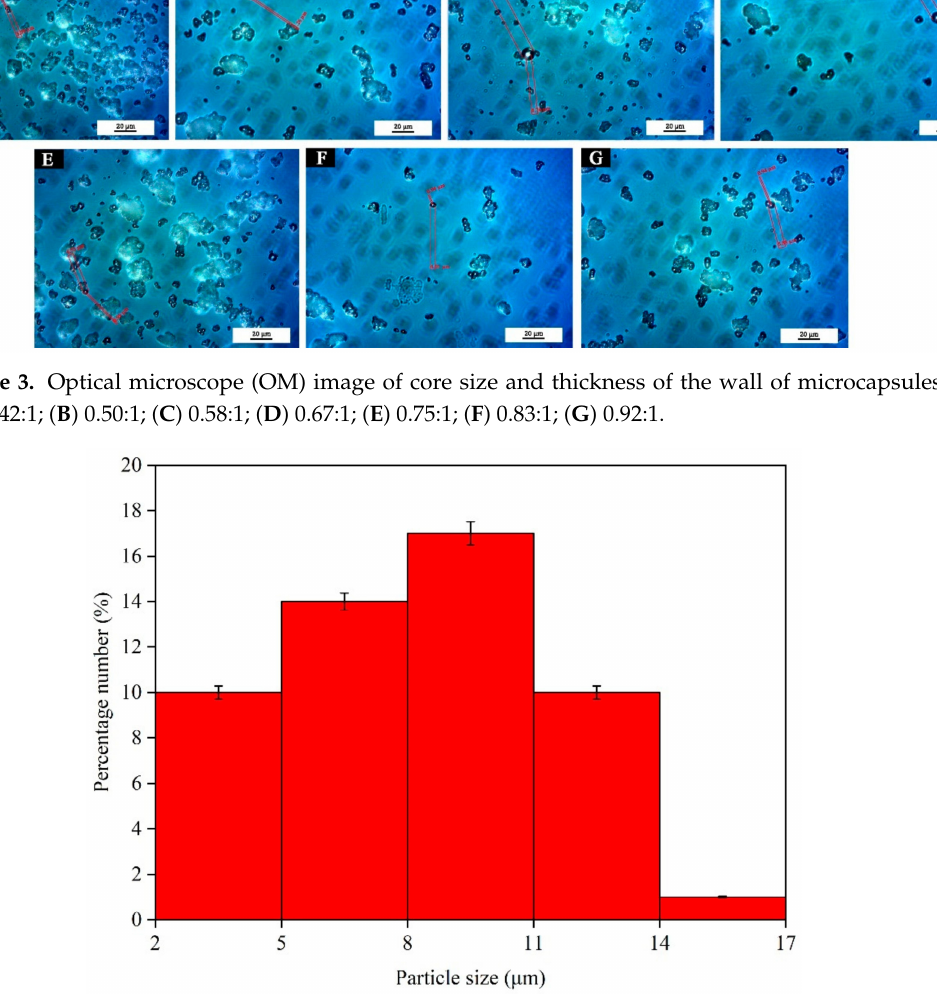
Figure 4. Particle-size distribution of the 0.58:1